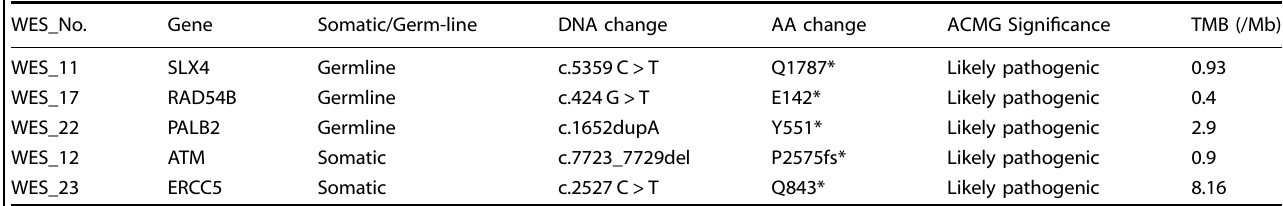
Table 1. Germline and somatic DDR gene mutations ( “ Likely pathogenic ” or “ Pathogenic ” ) in EPC from WES results. WES_No.